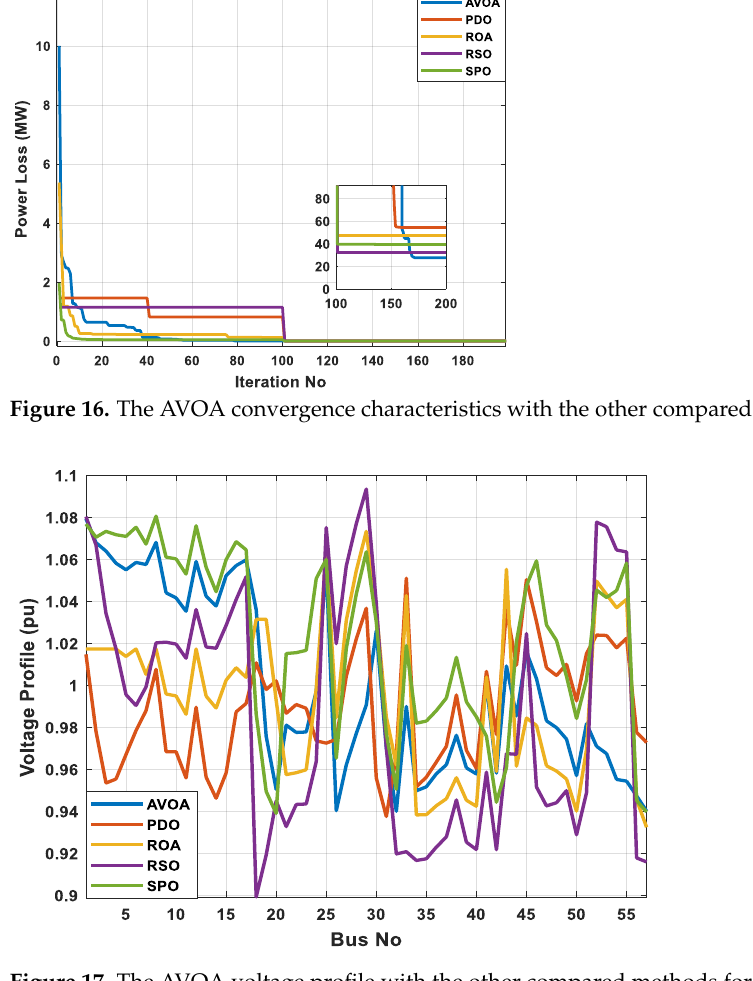
Figure 17. The AVOA voltage profile with the other compared methods for case 7.